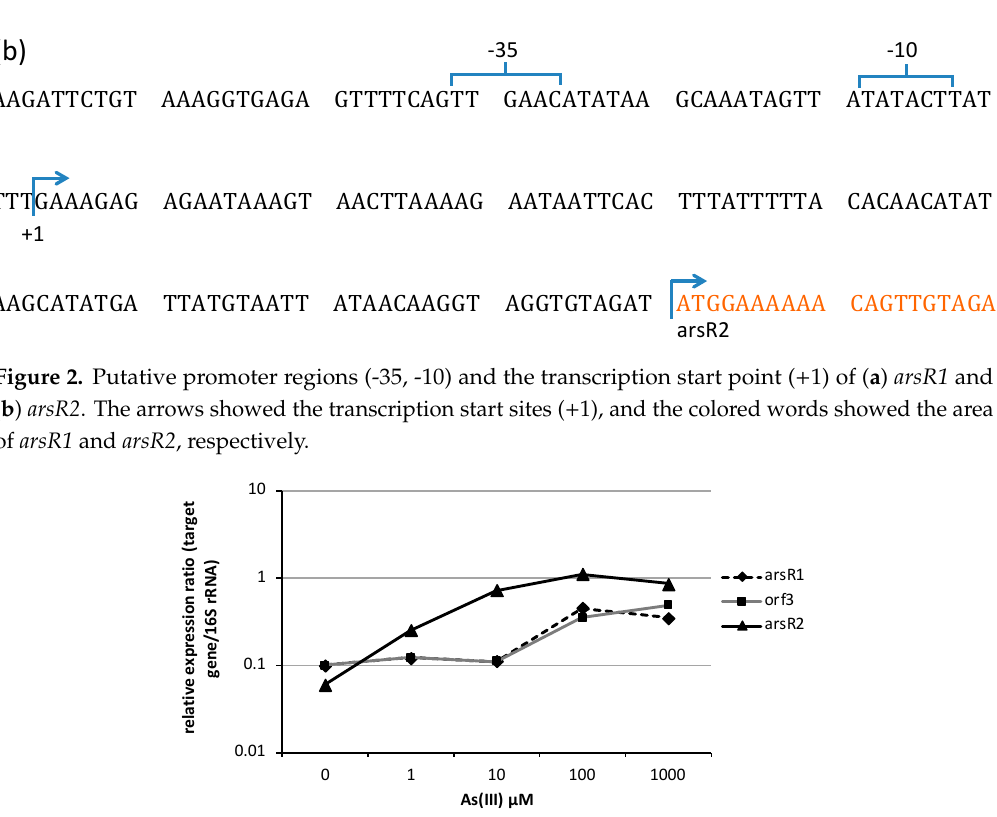
Figure 3. Relative transcription of ars operons under different concentrations of arsenite.